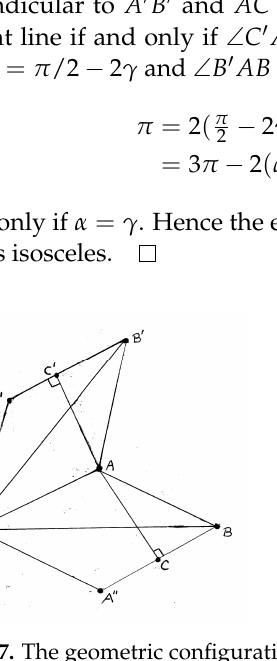
Figure 7. The geometric